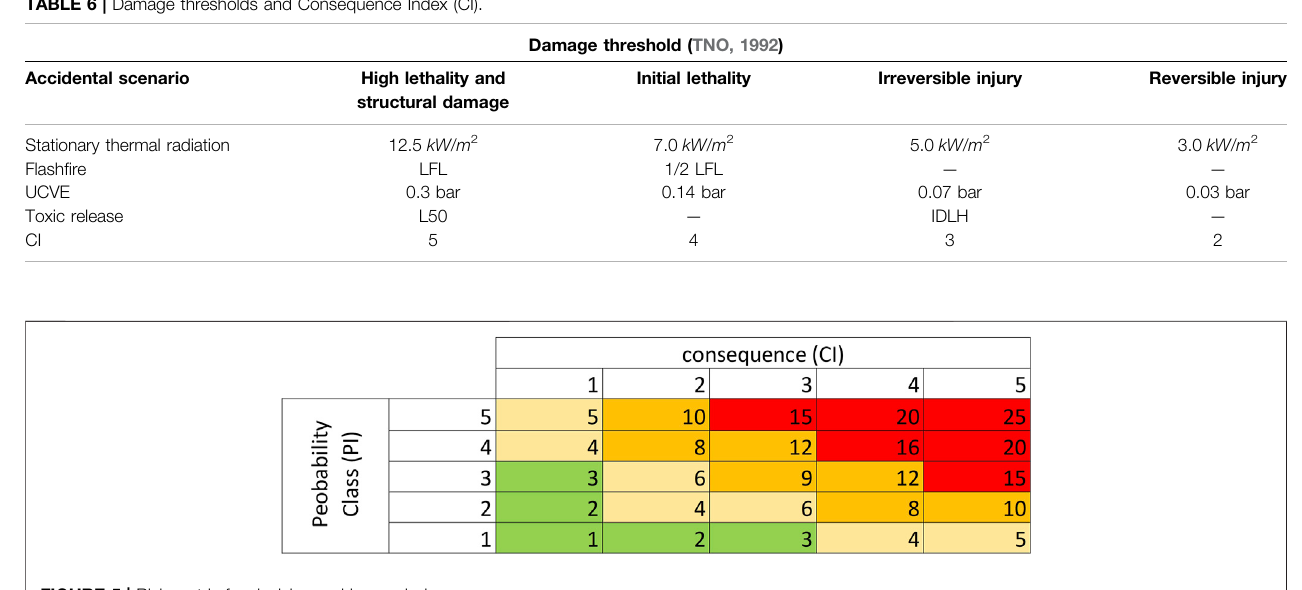
TABLE 6 | Damage thresholds and Consequence Index (CI).